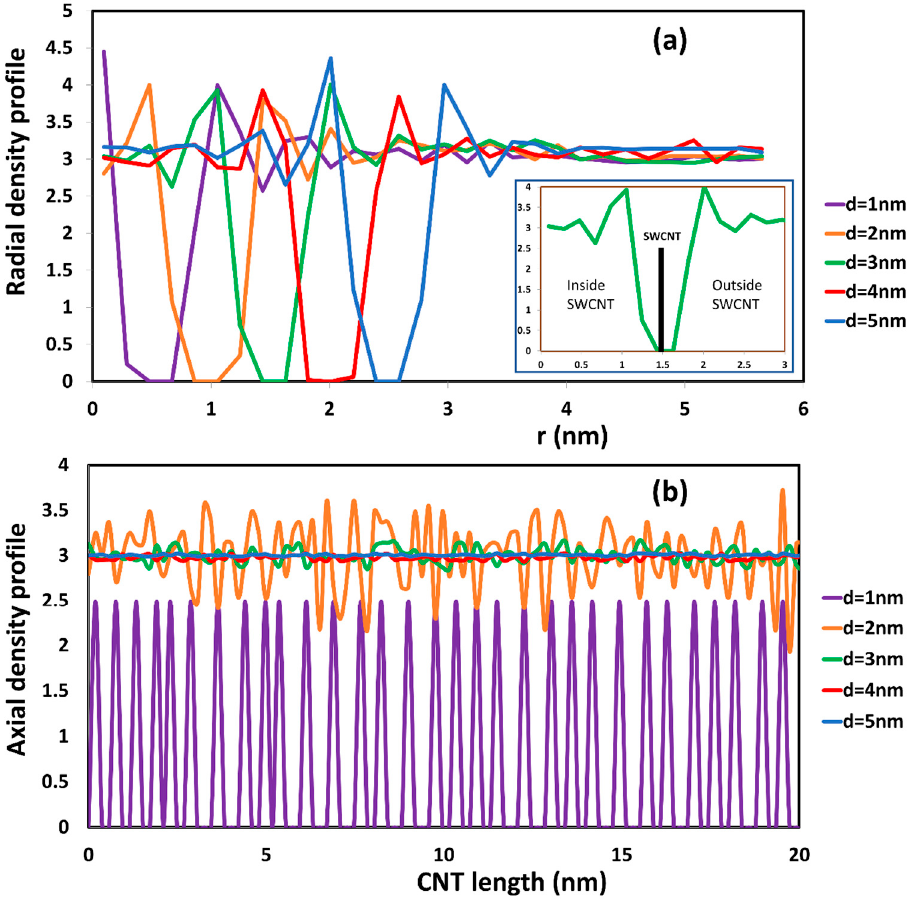
Figure 2. Radial ( a ) and axial ( b ) density profile of water inside different SWCNT in the equilibrium state. The inset plot in Figure 2a is an enlargement of the radial density profile with respect to distance (r) from 0 to 3 nm in the case of the SWCNT with diameter of 3 nm. The thick black line designates the position of the CNT wall. It is seen that the density profile to the right (exterior of the CNT) and to the left (interior of the CNT) is the same.